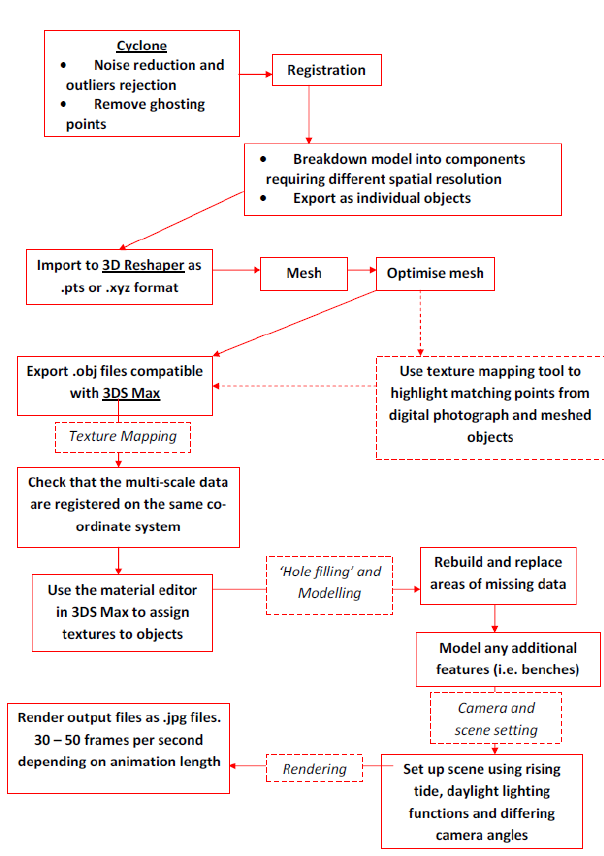
Figure 6 Workflow showing processing